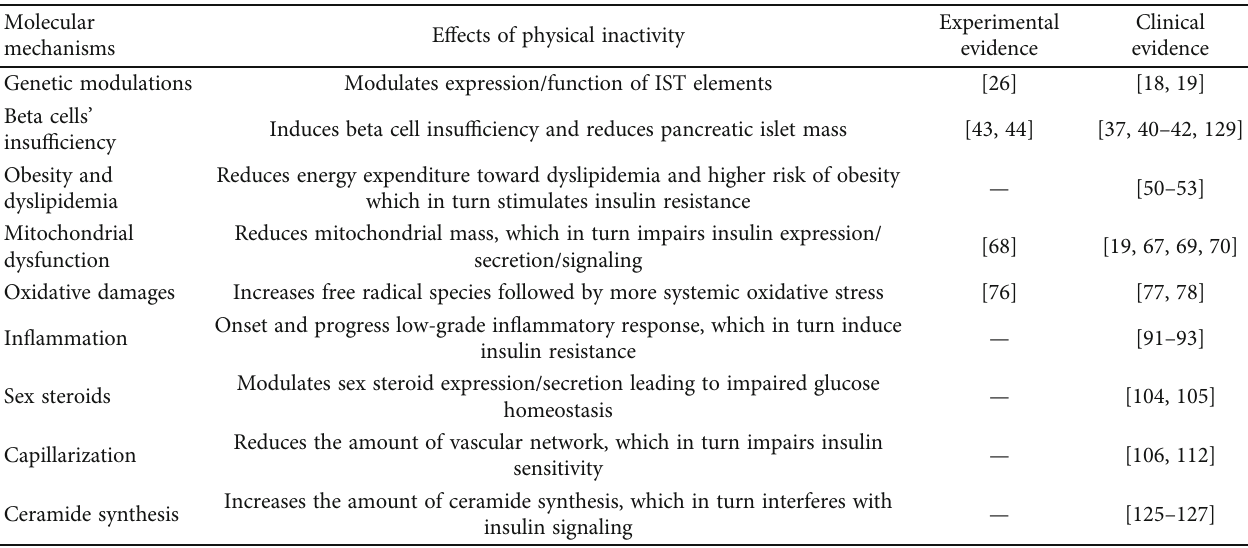
Table 1: Cellular pathways linking physical inactivity and insulin resistance (IST =insulin signal